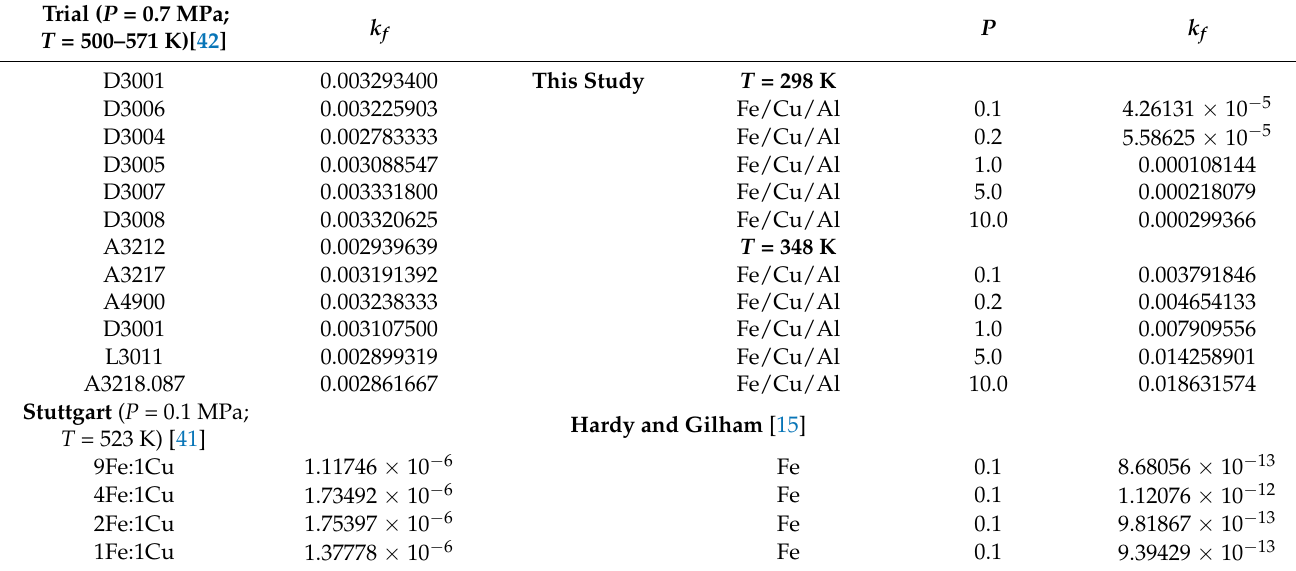
Table 25. Comparison of hydrocarbon production rates in this study and previous studies. P = pressure, MPa; P w = g Fe 0 L − 1 ; k f = forward rate constant g H 2 g Fe 0 L − 1 s − 1 . Data sources [15,41,42].